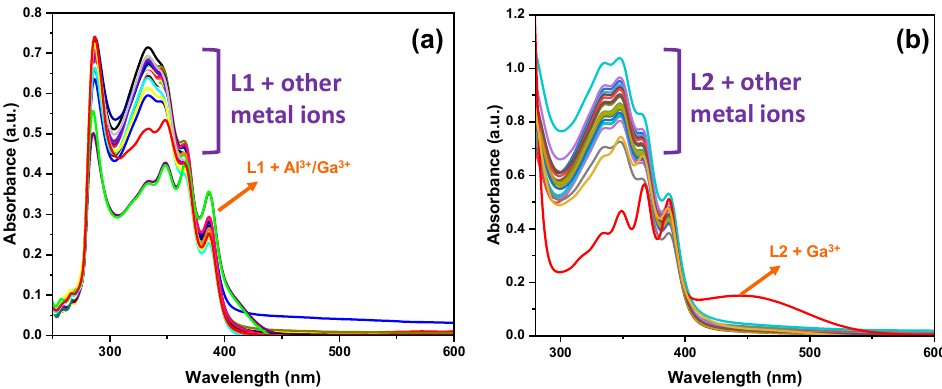
Figure 3. Absorption spectra of chemosensors ( a ) L1 (c, 20 µ M) and ( b ) L2 (c, 20 µ M) in EtOH in the Figure 3 . Absorption spectra of chemosensors ( a ) L1 (c, 20 μM) and ( b ) L2 (c, 20 μM) in EtOH in the presence of assorted metal ions (c, 50 μM). presence of assorted metal ions (c, 50 µ M).